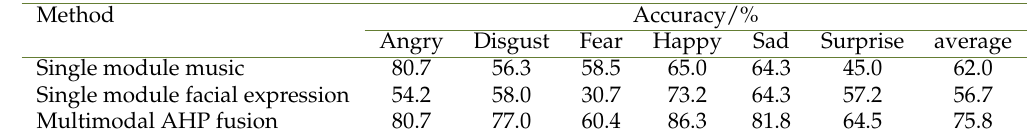
Table 3. Recognition results compared with other methods